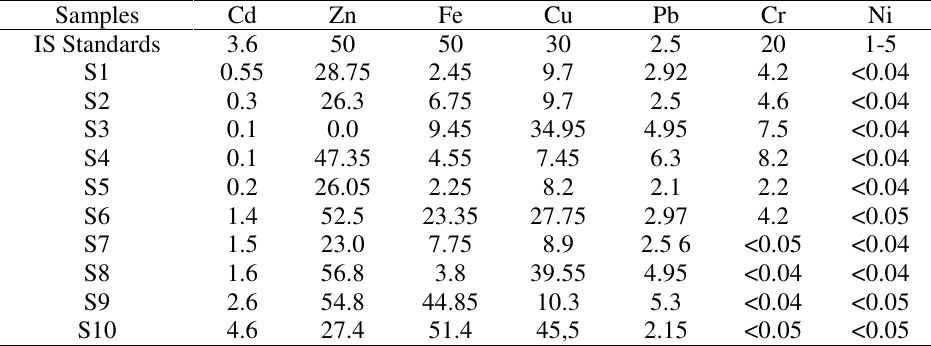
Table 5. Heavy metals (mg/kg of dry wt) in random samples of spinach collected from fields around the lakes of Bengaluru Samples